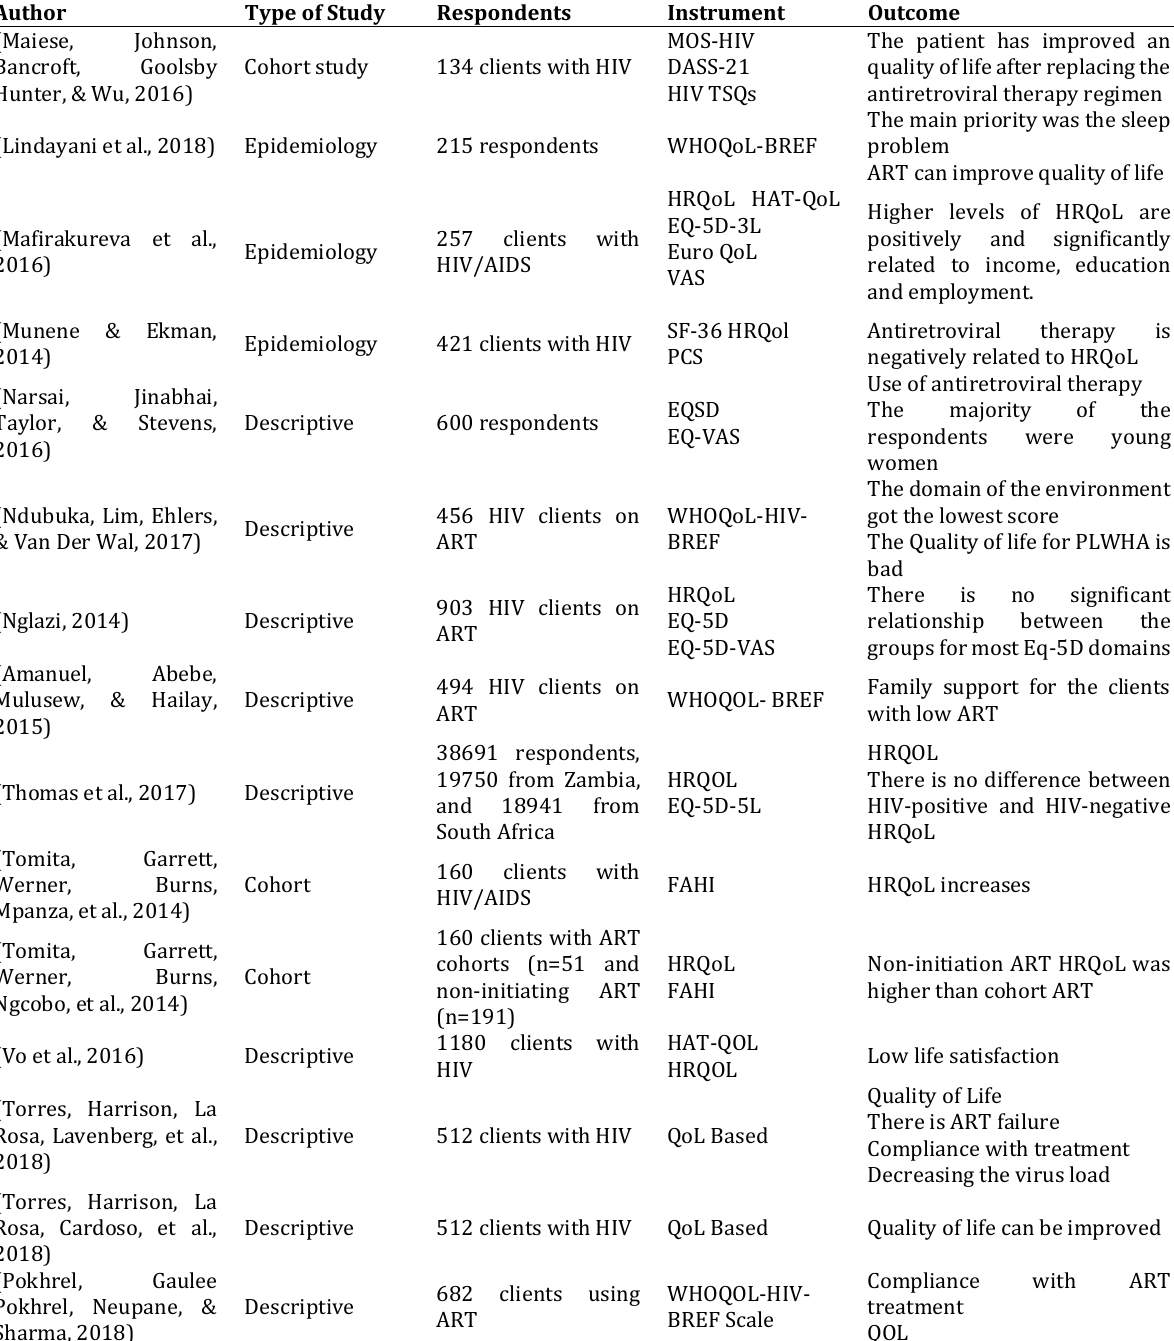
Table 2. Studies that formed the basis of the systematic